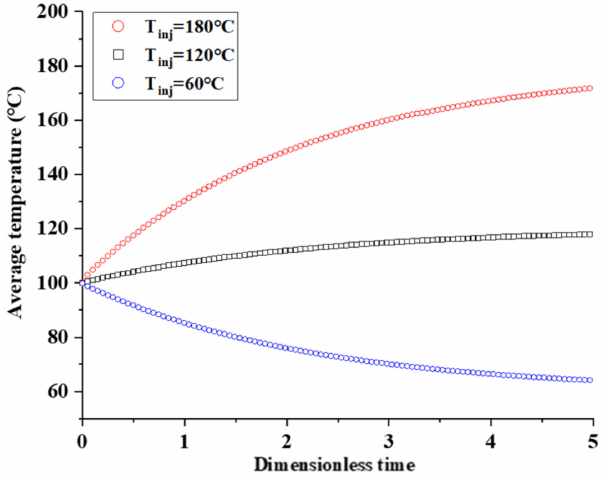
Figure 25. The average temperature at different